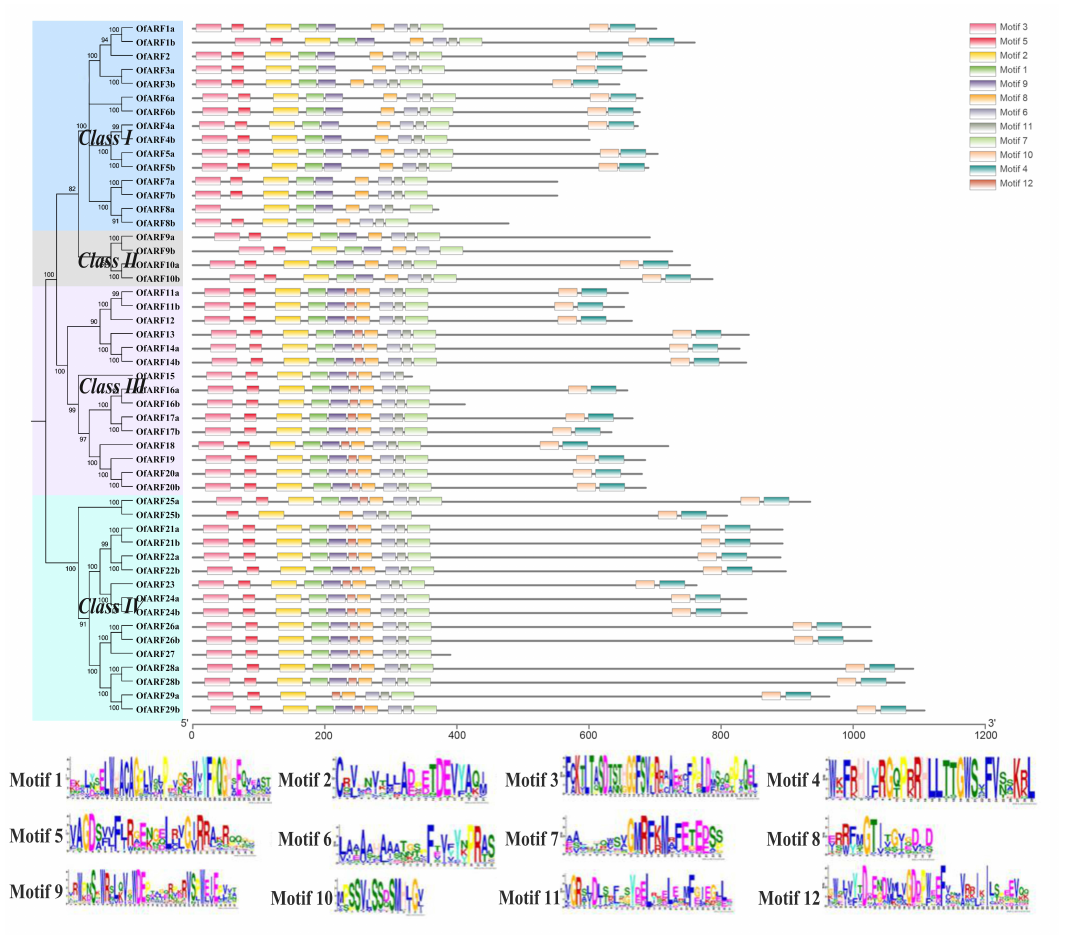
Figure 3. Motif distribution of the Osmanthus fragrans auxin response proteins